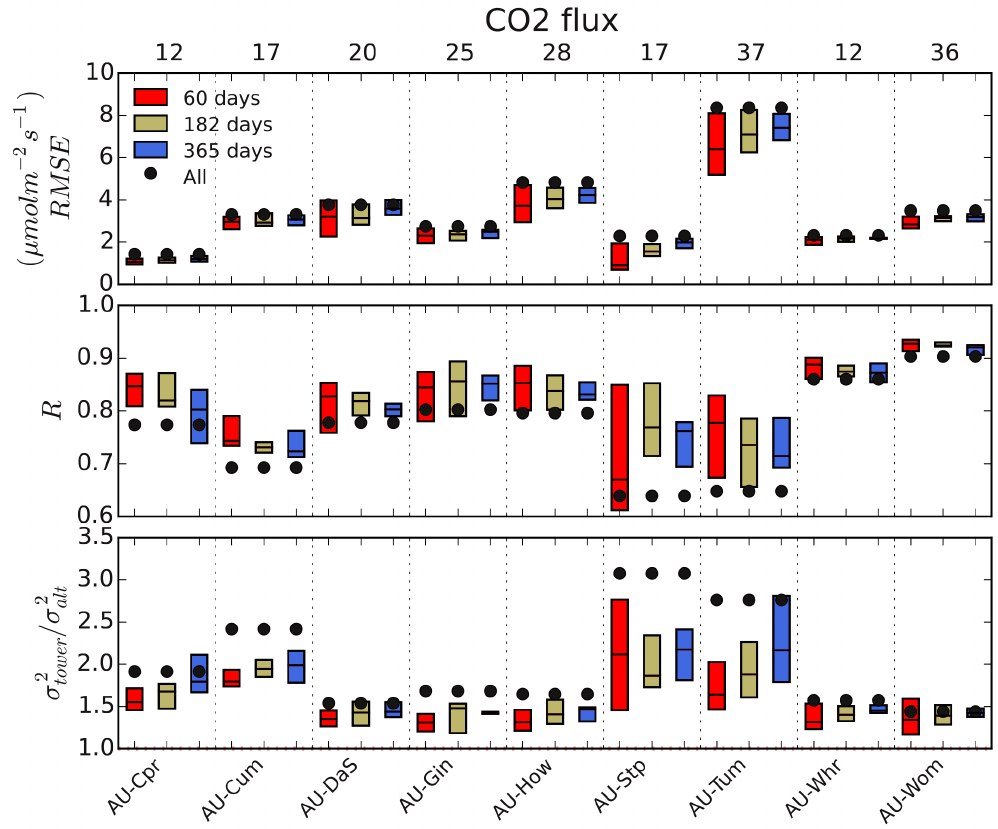
Figure 6. Statistics for different gap filling window lengths for CO 2 flux. Window lengths are 60 days (red), 182 days (khaki), 365 (blue) and whole length of data set (black dots). Box lengths represent the 75 and 25% quartiles with the median plotted across the boxes as a solid line. Numbers at the top are the percentage of missing data that are gap